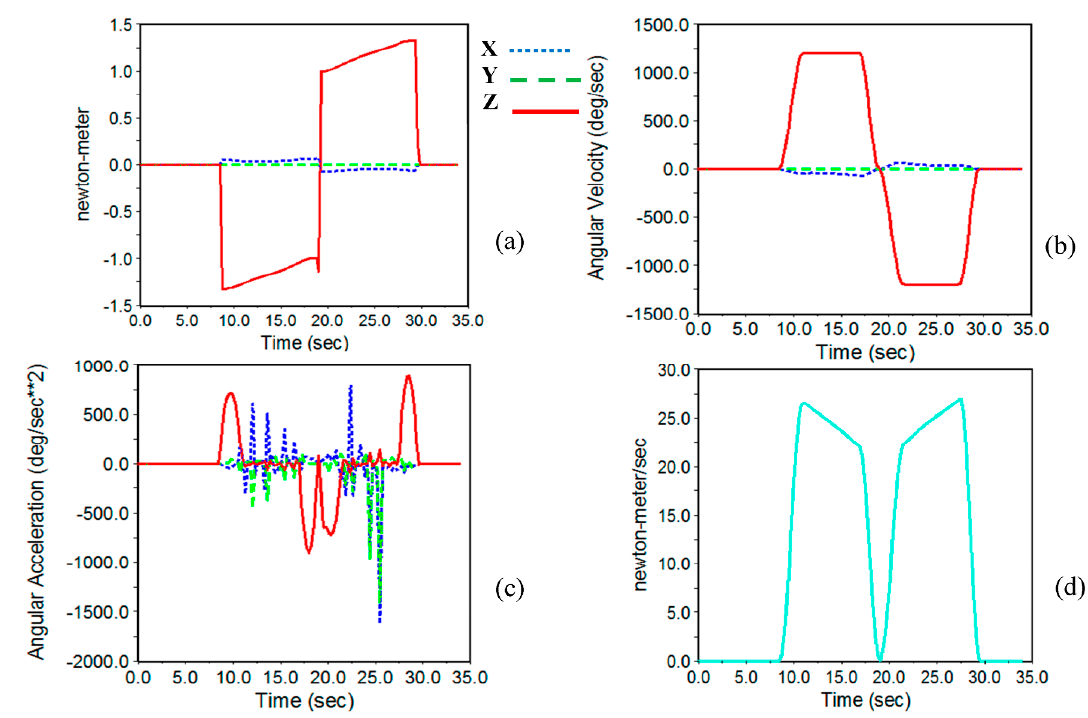
Figure 17. Results of ADAMS software simulation to determine the motor characteristics of the belly-cutting subset (4 fish per minute). In this figure, ( a – d ) are torque, angular velocity, angular acceleration, and required power respectively.